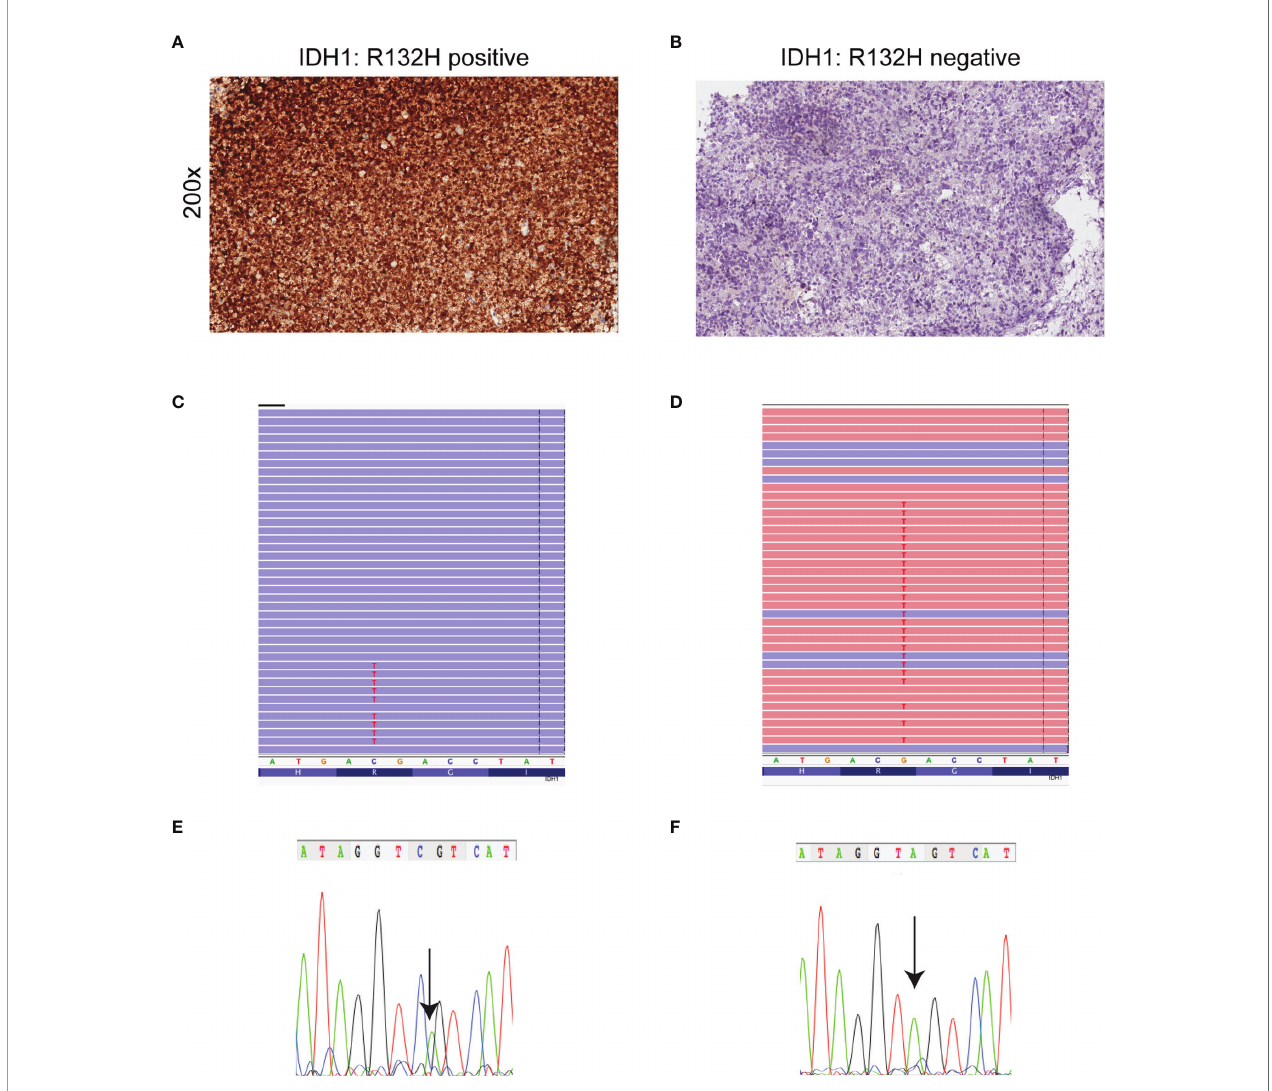
FIGURE 2 | Detection of mutant IDH1 by immunohistochemistry, NGS and Sanger sequencing. (A) Astrocytoma cells are diffusely and strongly stained with anti- IDH1 (R132H) antibody (immunoperoxidase; original magni fi cation 200x). (B) Corresponding IDH1 c.395G>A (p. R132H) mutation detected by NGS. Results were viewed in the Integrative Genomics Viewer (IGV). (C) The chromatogram showing representative sequencing results of IDH1 c.395G>A (p. R132H). (D) Absence of IDH1 (R132H) immunoreactivity in a IDH1 - (R132S)-mutant astrocytoma. (E) IDH1 c.394C>A (p. R132S) mutation detected by NGS. Results were viewed in the IGV. (F) The chromatogram showing the representative sequencing results of IDH1 c.394C>A. Note that IDH1 is a negative-sense gene with respect to the genomic reference sequence. Thus, any nucleotide change is displayed as reverse complement. The arrow symbols on chromatogram indicate the place of